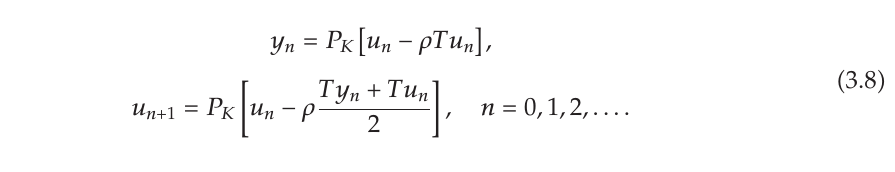
Algorithm 3.6. For a given u 0 ∈ K , find the approximate solution u n (cid:8) 1 by the iterative